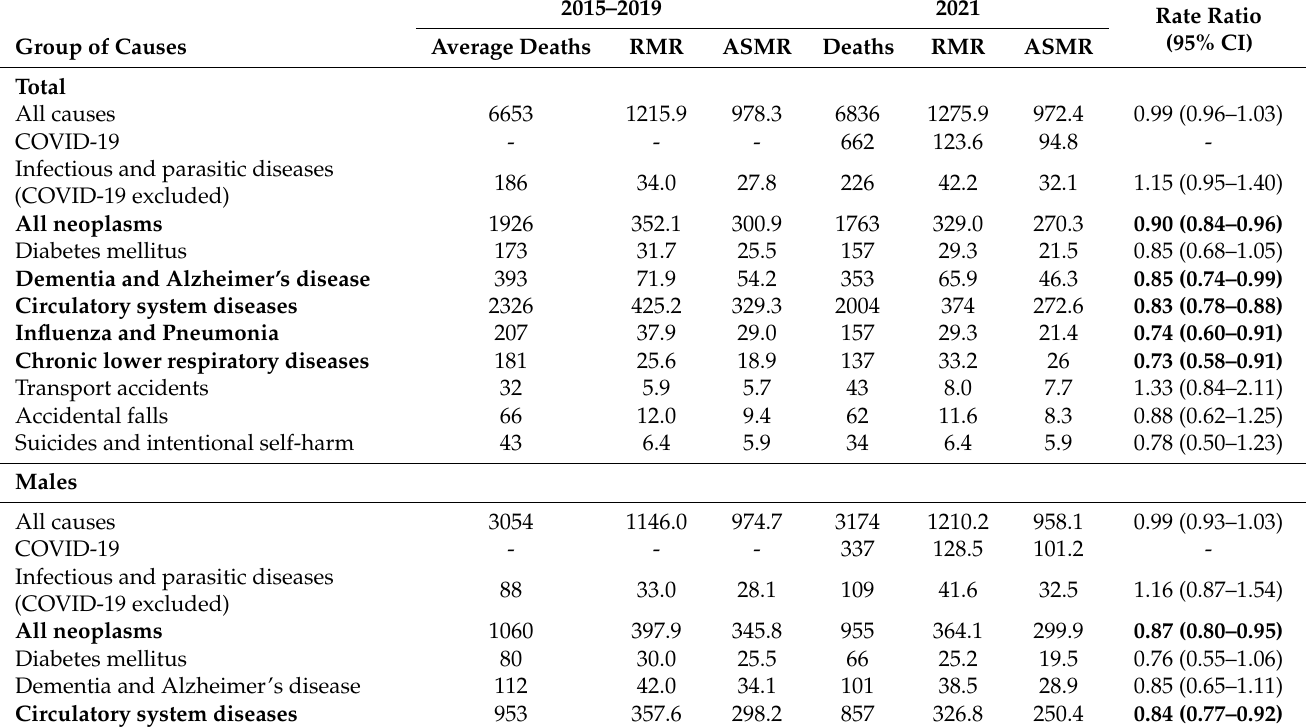
Table 1. Number of observed deaths, raw mortality rates (RMR) and age-standardized 1 mortality rates (ASMR/100,000) from all causes and selected groups of causes, in the total, males and females population, at all ages, in 2015–2019 and 2021, the Rate Ratio between ASMRs in 2021 and 2015–2019 and corresponding 95% confidence interval (CI). Pavia province, Lombardy region,